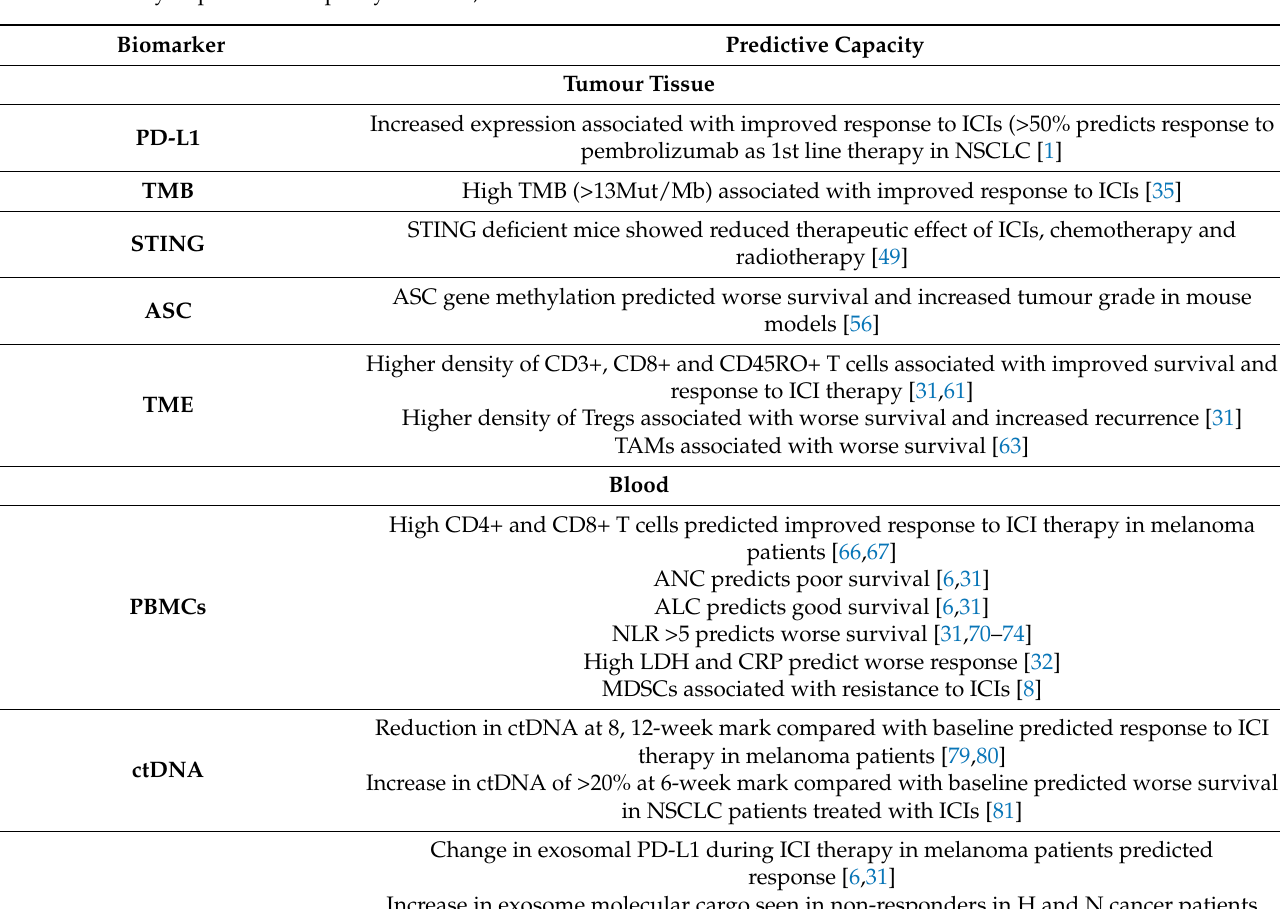
Table 4. Summary of predictive capacity of tissue, blood and microbiome biomarkers.